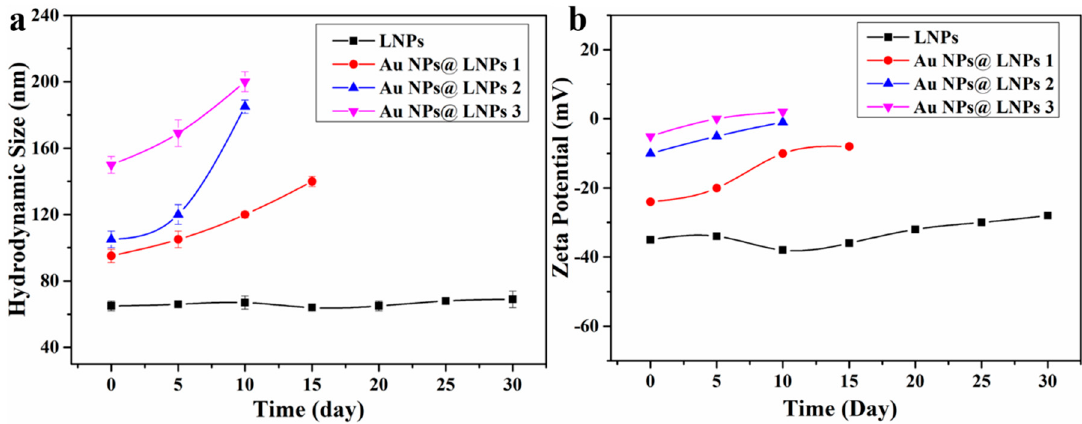
Figure 5. Variation of hydrodynamic size ( a ) and zeta potential ( b ) of LNPs and the composites during long ‐ term storage.